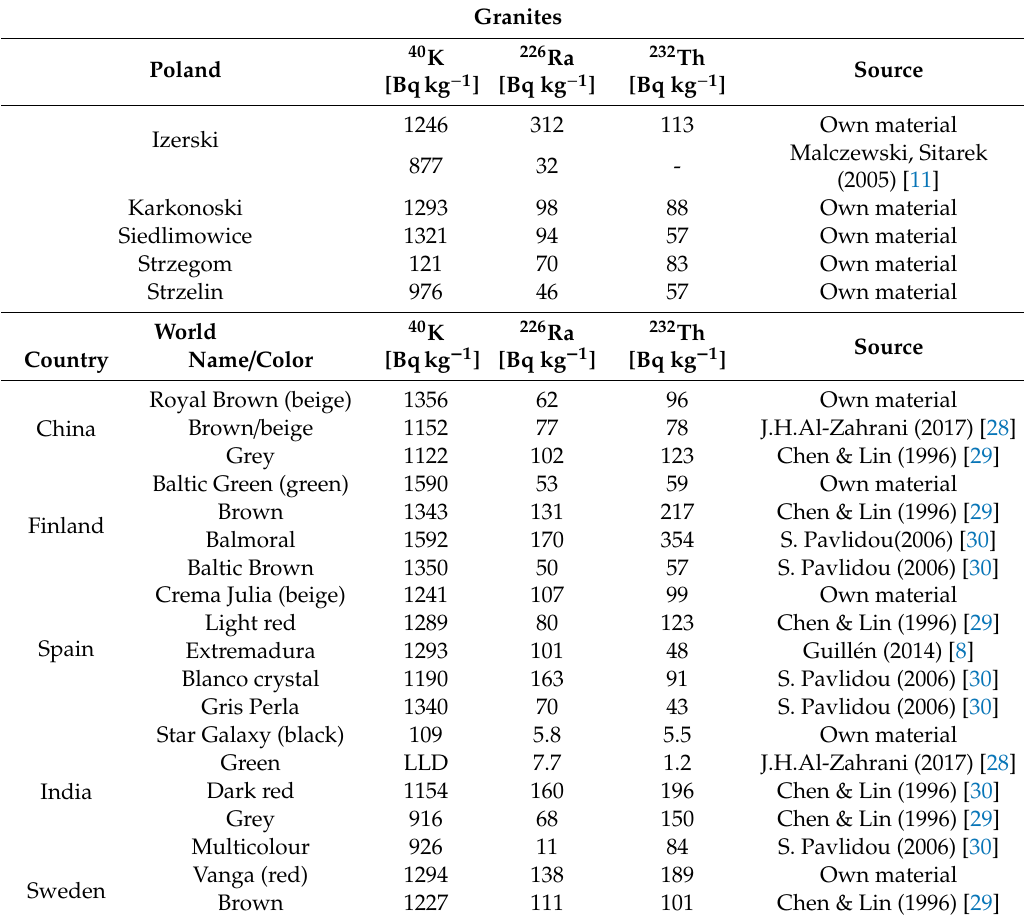
Table 2. Comparison of obtained research results with literature data.